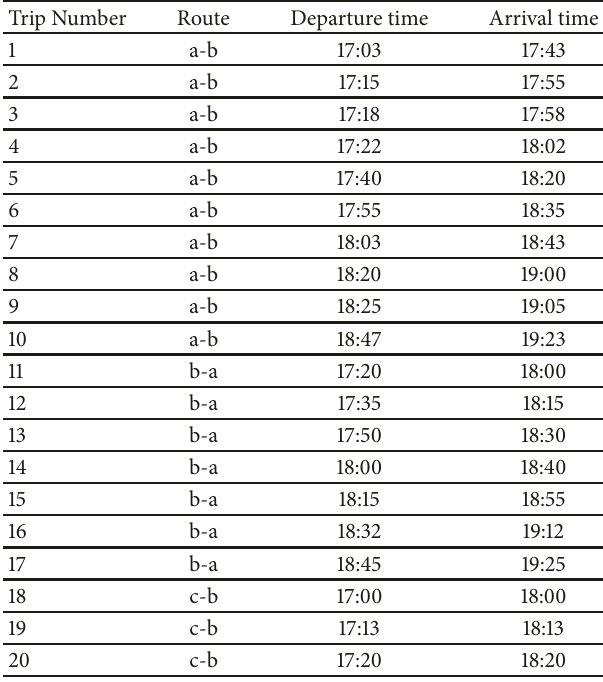
Table 2: A 20-trip schedule with the four terminals.